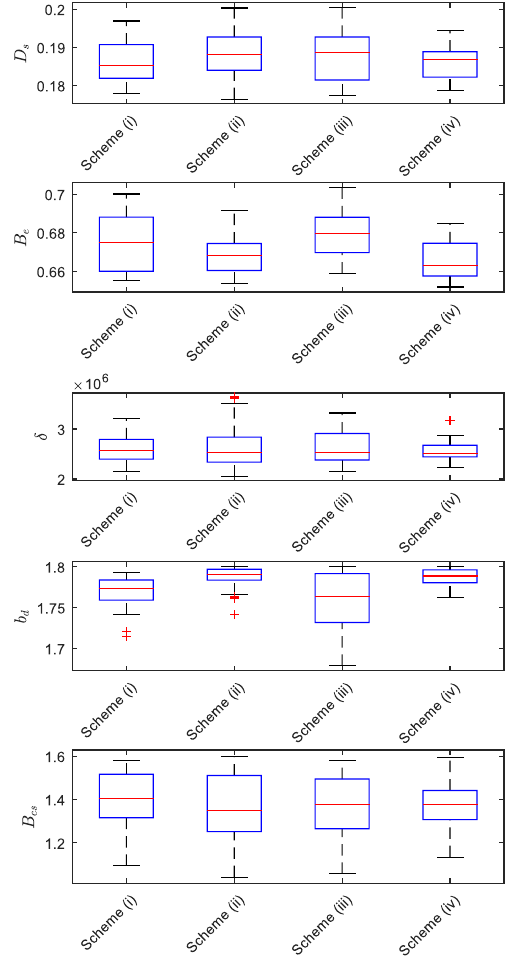
Figure 4. Decision variables distribution (filtered of 30 runs) for MOALO.